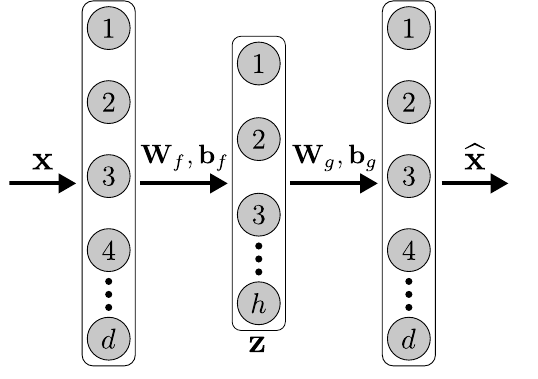
Figure 1. Single layer